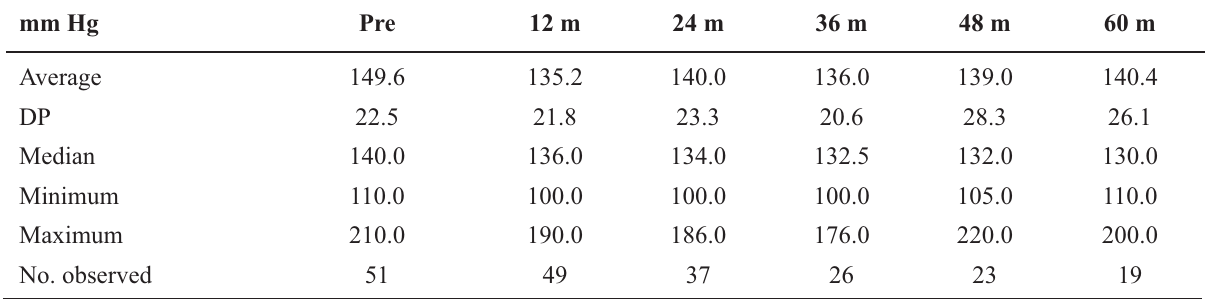
Table 2 – Averages of the systolic blood pressures from the pre-operative period until 60 months pos-nephrectomy. mm Hg